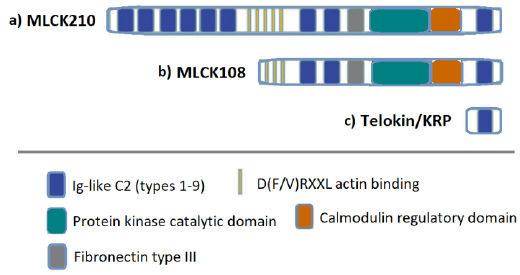
Figure 2. Myosin Light Chain Kinase gene ( MYLK ) products; schematic representation of each protein and its domain structure. The gene MYLK encodes 3 proteins: MLCK210 (210 – 220 kDa), MLCK108 (110 – 140 kDa), and telokin/kinase-related protein (KRP) (based on [44,46]).